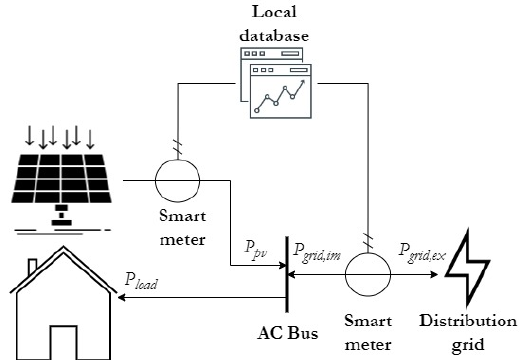
Figure 1. Simple block diagram of the selected pilots in Cyprus.